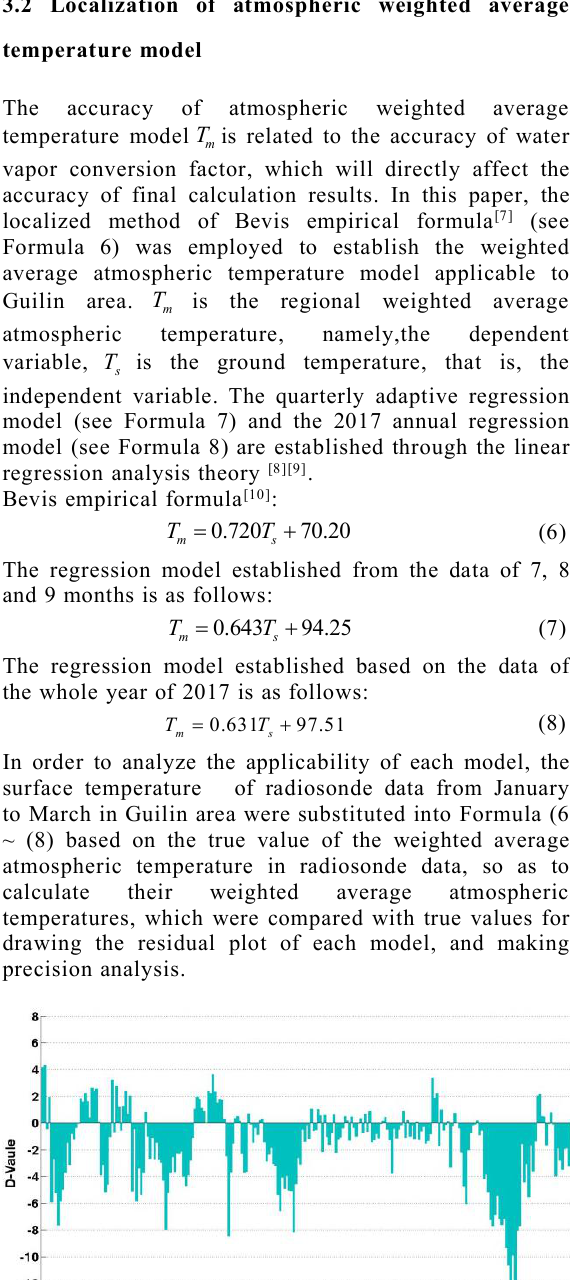
Figure 3. Formula model residual errors based on sounding data in q3 2017